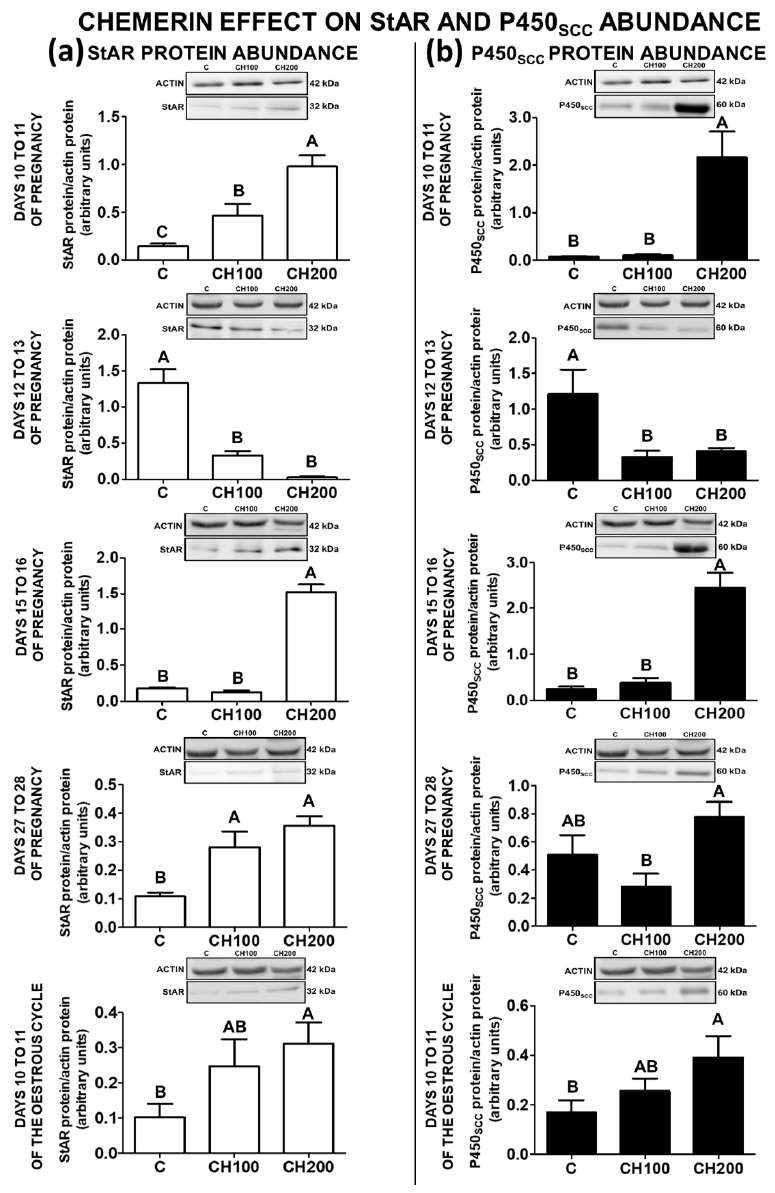
Figure 2. The effect of chemerin on StAR and P450 SCC protein abundance. The influence of chemerin (100, 200 ng/mL) on the protein abundance of steroidogenic acute regulatory protein (StAR; ( a )) and P450 side-chain cleavage enzyme (P450 SCC ; ( b )) in the in-vitro-incubated endometrial tissue explants collected from pigs on days 10 to 11, 12 to 13, 15 to 16, and 27 to 28 of pregnancy, and on days 10 to 11 of the oestrous cycle. The protein abundance of StAR and P450 SCC was evaluated using Western blot analysis. Upper panels—representative immunoblots, lower panels—densitometry analysis of target proteins’ relative content normalised with the actin protein. Data are presented as the mean ± standard error of the mean ( n = 5). Bars with different letters are significantly different at p < 0.05. C—control; CH100—chemerin 100 ng/mL; CH200—chemerin 200